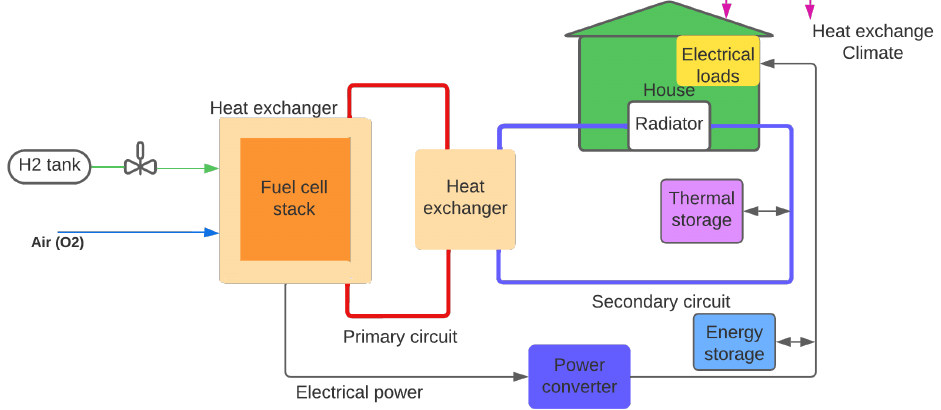
Figure 5. CHP system